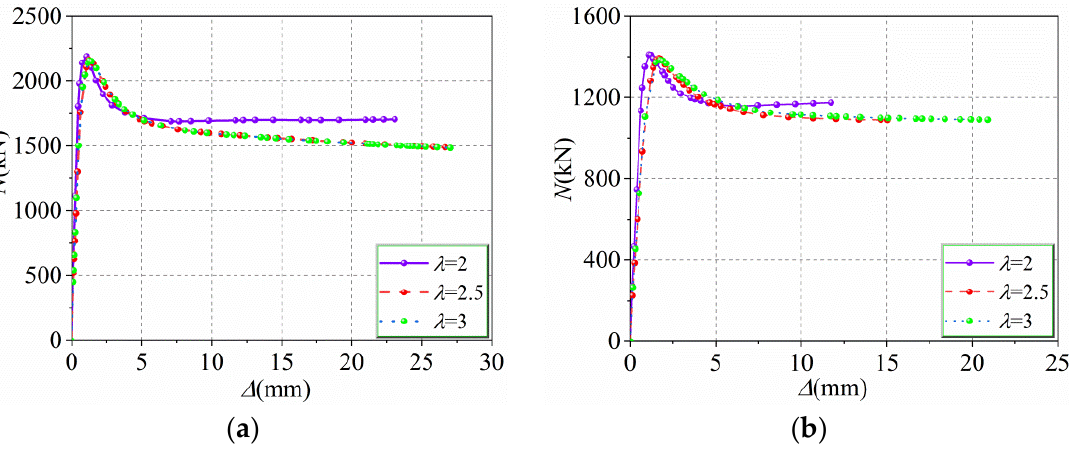
Figure 10. Curves of load–deflection for specimens with various λ : ( a ) e = 20 mm; ( b ) e = 50 mm.